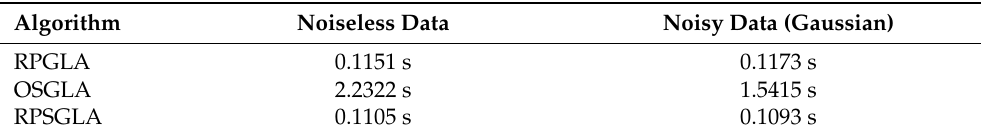
Table 2. The average running time (repeating 100 times) of the RPGLA, RPSGLA, and OSGLA obtained on noiseless data and noisy data (Gaussian).